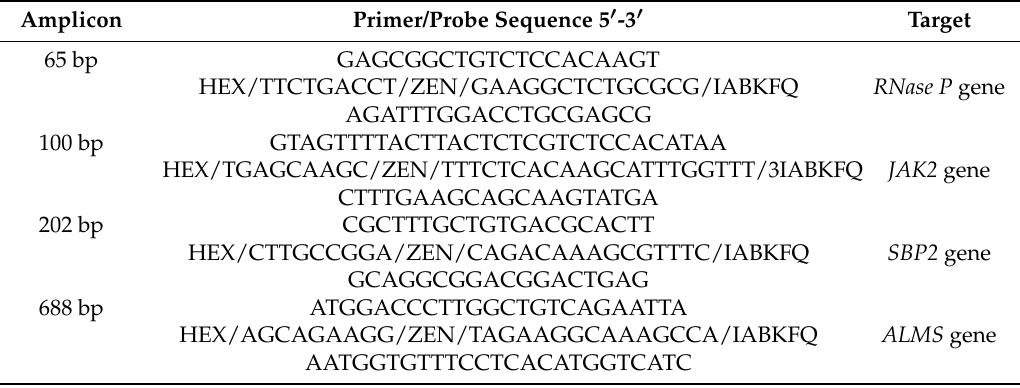
Table 1. Primer and probe sets used in serum DNA enrichment